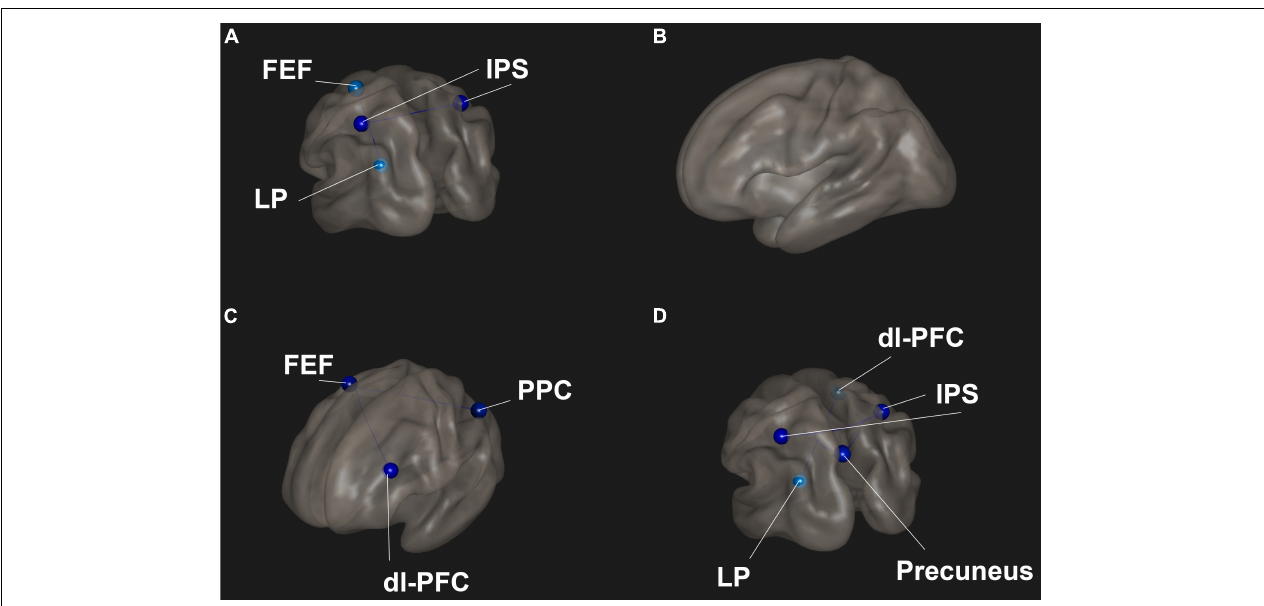
FIGURE 3 | Functional connectivities were compared between meditators and controls for each condition. (A) Resting-state pre-program – meditators had decreased connectivity between the front eye fields (FEF) and lateral parietal (LP) lobe and between the left and right intraparietal sulci (IPS). (B) Focused breathing pre-program – no significant difference between the groups. (C) Resting-state post program – meditators had significantly reduced connectivity between the FEF and dorsolateral prefrontal cortex (dl-PFC) and posterior parietal cortex (PPC). (D) Focused breathing post program – meditators had significantly reduced connectivity between the dl-PFC and LP and the IPS and posterior cingulate cortex (PCC). Red indicates increased connectivity and blue indicates decreased connectivity.